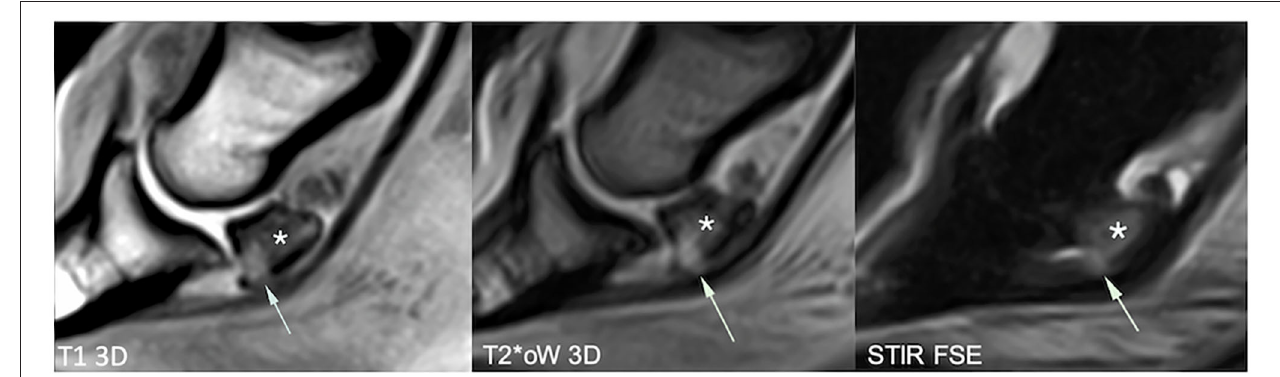
FIGURE 4 | Sagittal magnetic resonance (MR) images focused on the navicular bone. There is a distal palmar compact bone erosion, characterized by disruption of the palmar compact and hyperintense signal intensity in all MR sequences, penetrating the adjacent palmar spongiosa (arrows). The navicular bone also shows extensive T1 hypointensity, STIR hyperintensity, and mixed T2*oW signal in the distal two-thirds of the palmar spongiosa, consistent with bone edema-like signal (asterisk). T1 3D, tridimensional gradient echo T1 weighted sequence; T2*oW 3D, tridimensional out of phase gradient echo T2* weighted sequence; STIR FSE, fast spin echo short tau inversion recovery weighted sequence; US, Ultrasonography.